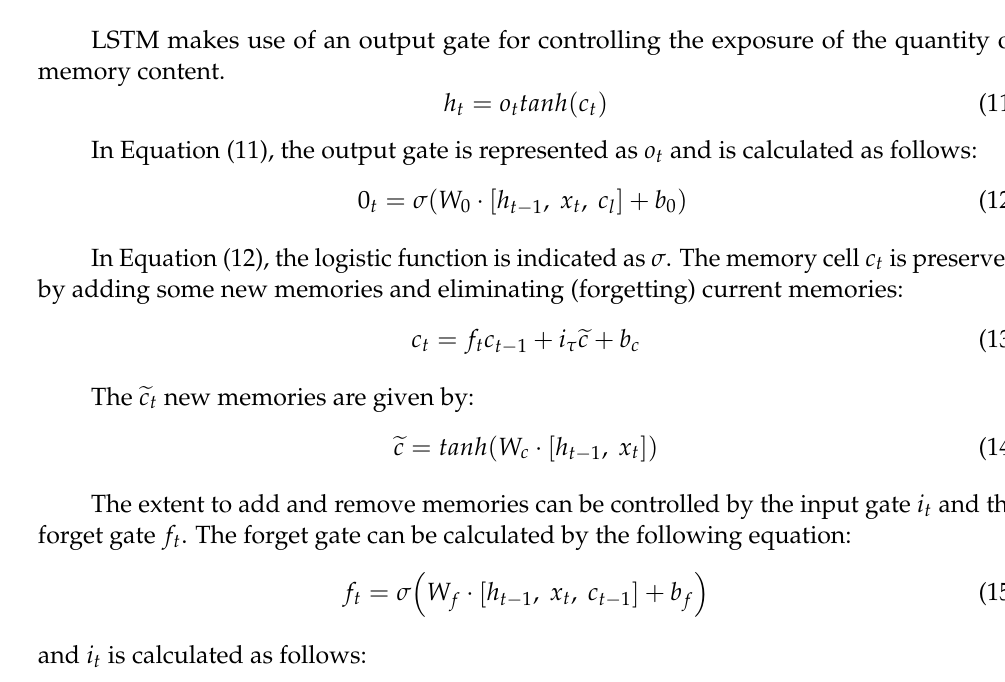
Figure 2. Architecture of GRU.